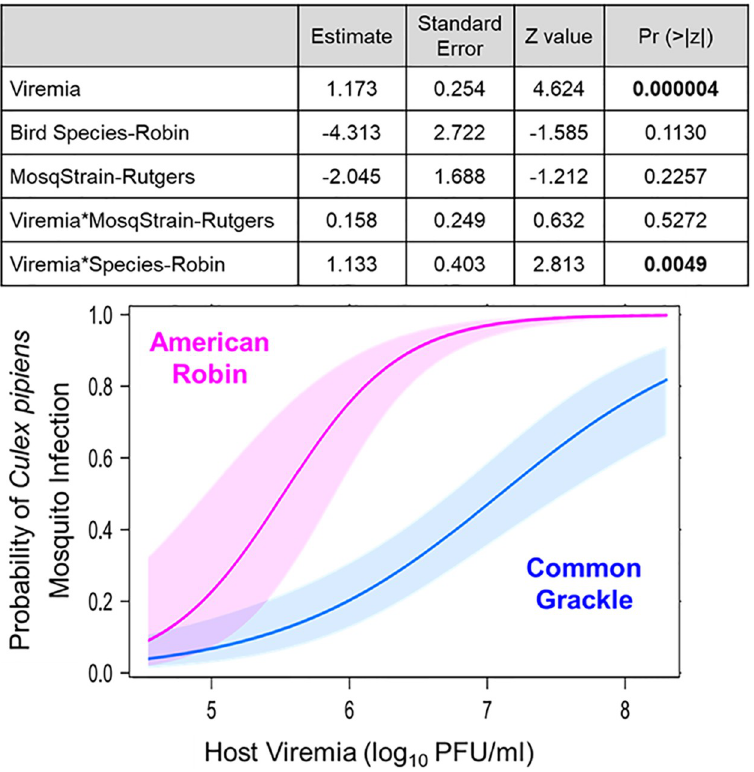
Fig 1. Relationship between West Nile virus viremia in American robins versus common grackles and infectiousness to Culex pipiens mosquitoes, as modeled by logistic regression including a random effects term for individual birds. Shaded areas in plot represent 95% confidence